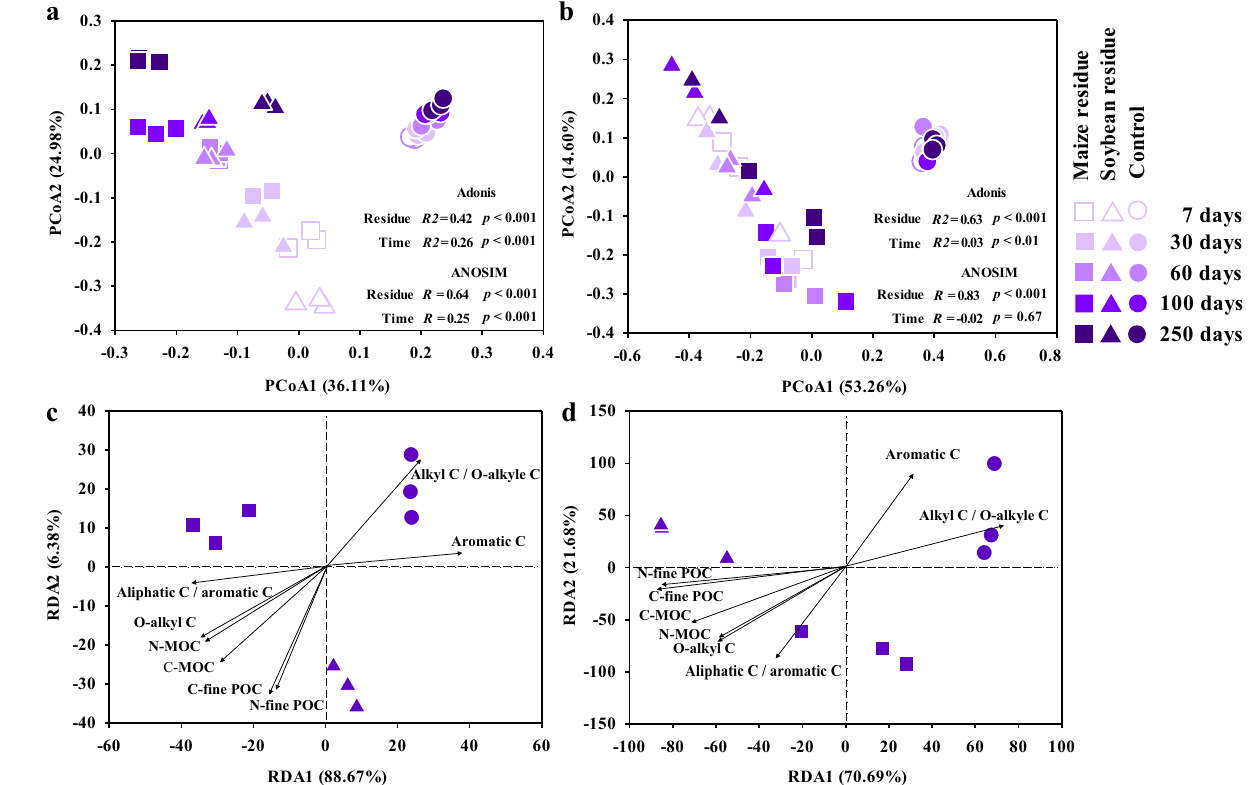
Fig. 3 Microbial community composition. Principal coordinate analysis (PCoA) of bacterial ( a ) and fungal ( b ) communities in a Mollisol amended with maize and soybean residues for 7, 30, 60, 100 and 250 days ( n = 3). Redundancy analysis (RDA) for the association of bacterial ( c ) and fungal ( d ) communities at the OTU level with C and N concentrations in the fi ne particulate ( fi ne-POC) and mineral-associated C (MOC) fractions, and functional groups of